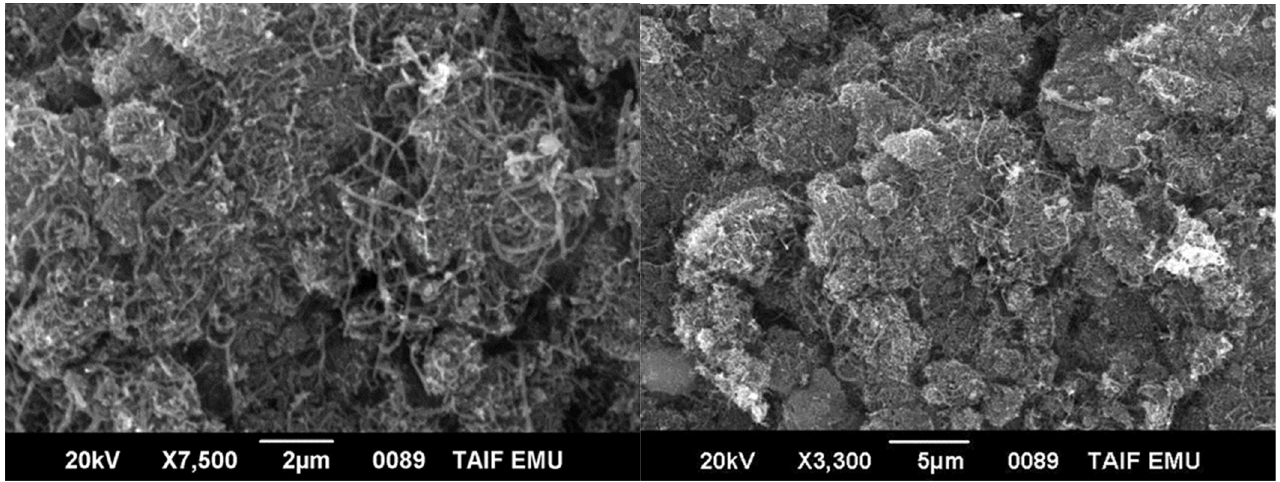
Figure 7. SEM micrographs of the multi-walled fullerene CNT.